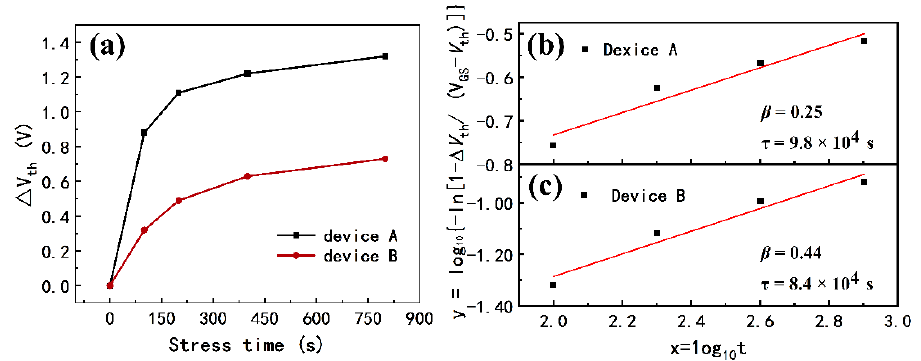
Figure 6. ( a ) The dependence of threshold voltage shift on stress time of device A and B. ( b ) and ( c ) are the fitted curves described by Equation (1) of device A and B, respectively.